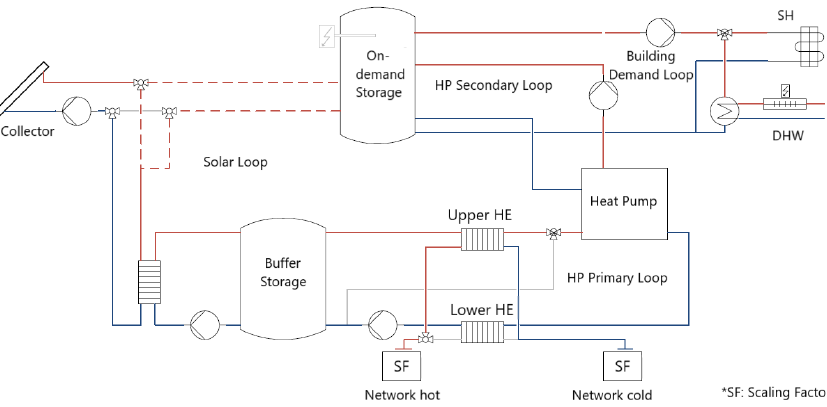
Figure 5. Single building model in the Carnot Toolbox (Figure translated from [21] (p.